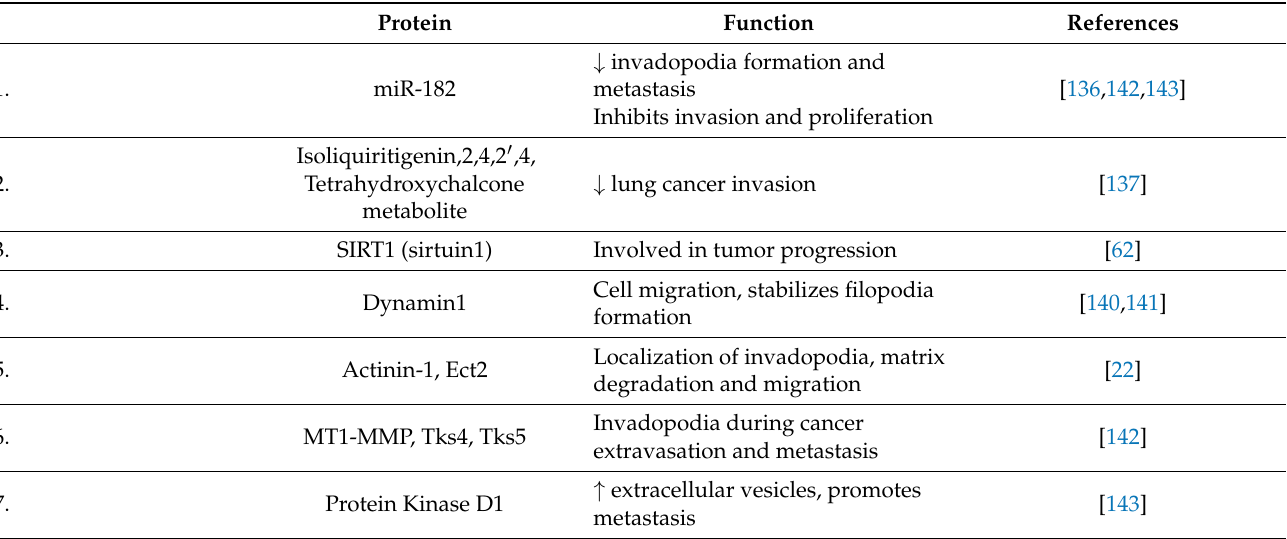
Table 2. Role of CTTN in association with other signaling components in regulating cellular mecha- nisms in lung cancer (Figure